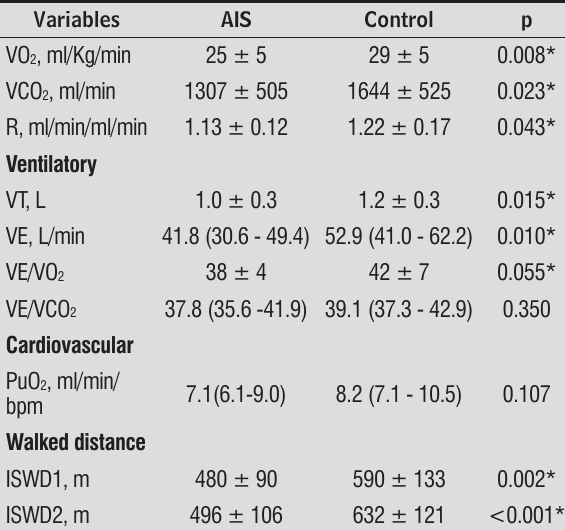
Table 1 - Comparison of pulmonary function and variables